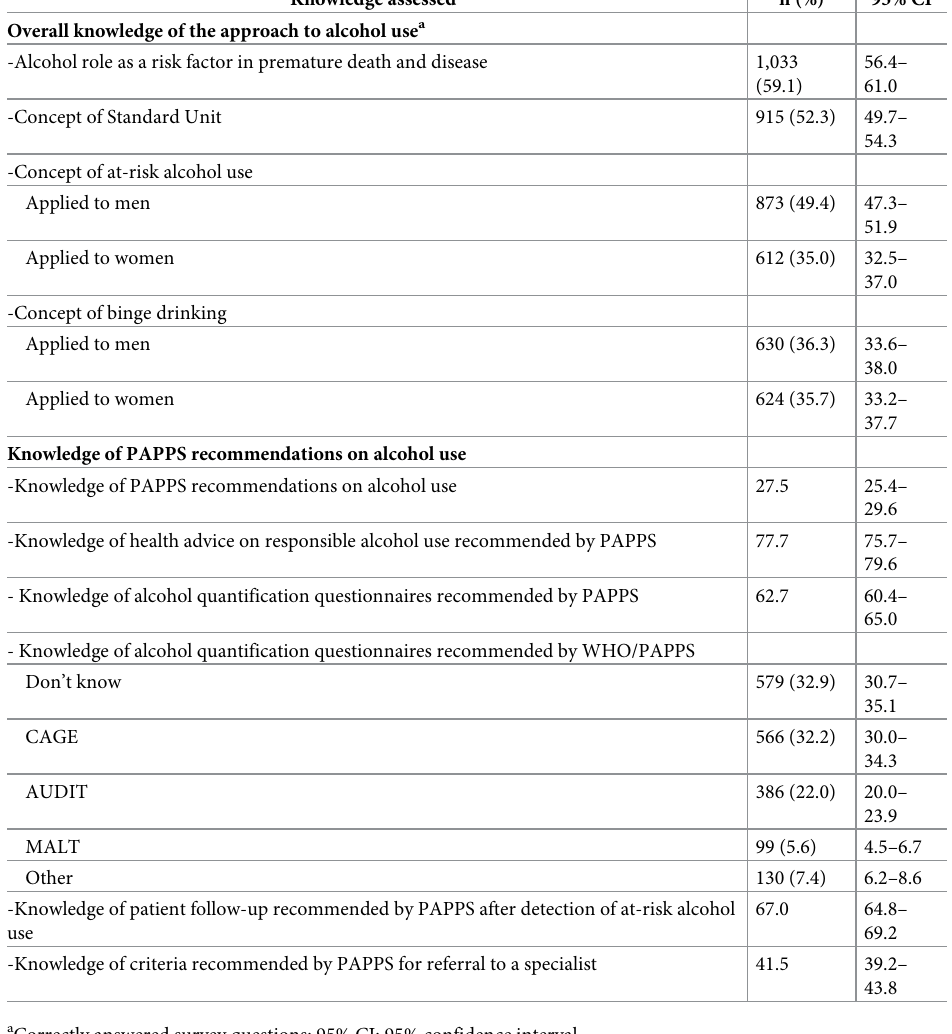
Table 1. Knowledge of PC professionals regarding approach to